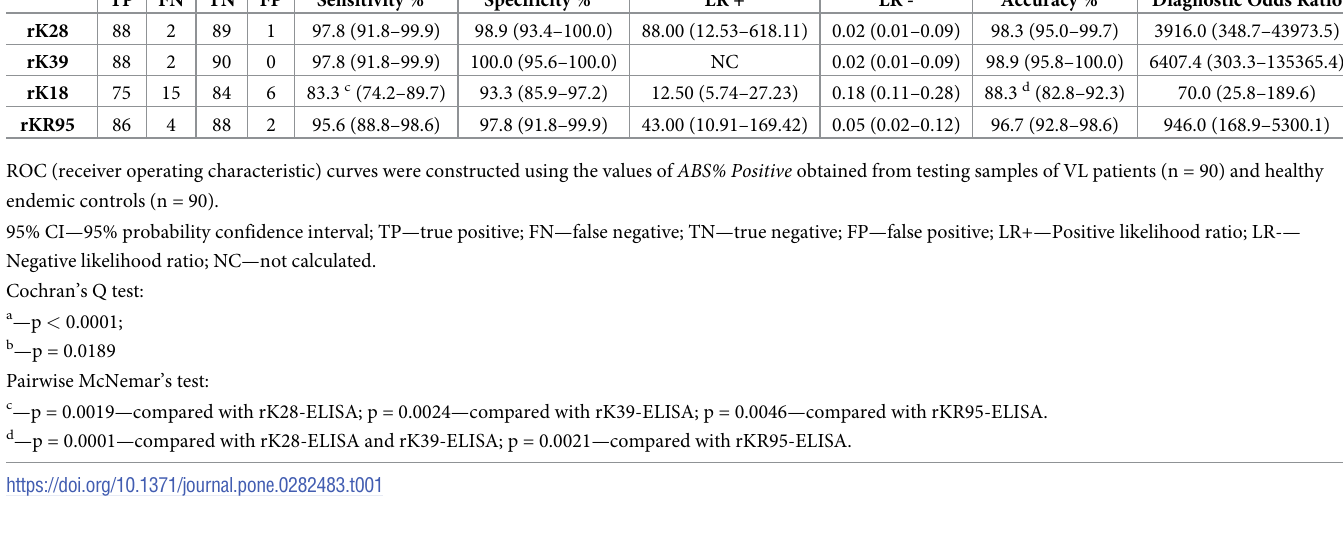
Table 1. Diagnostic performance parameters obtained by ELISA with recombinant antigens determined by ROC curves (Panel 1). Antigens Number of